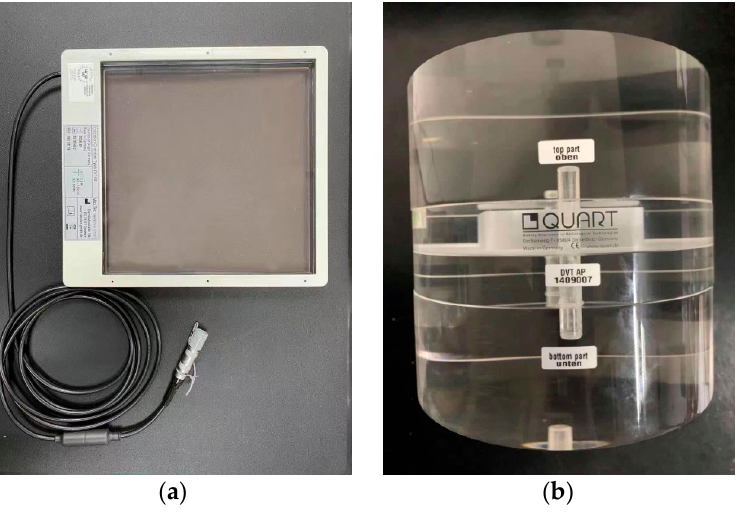
Figure 1. ( a ) VacuTec KAP meter and ( b ) QUART DVT_AP